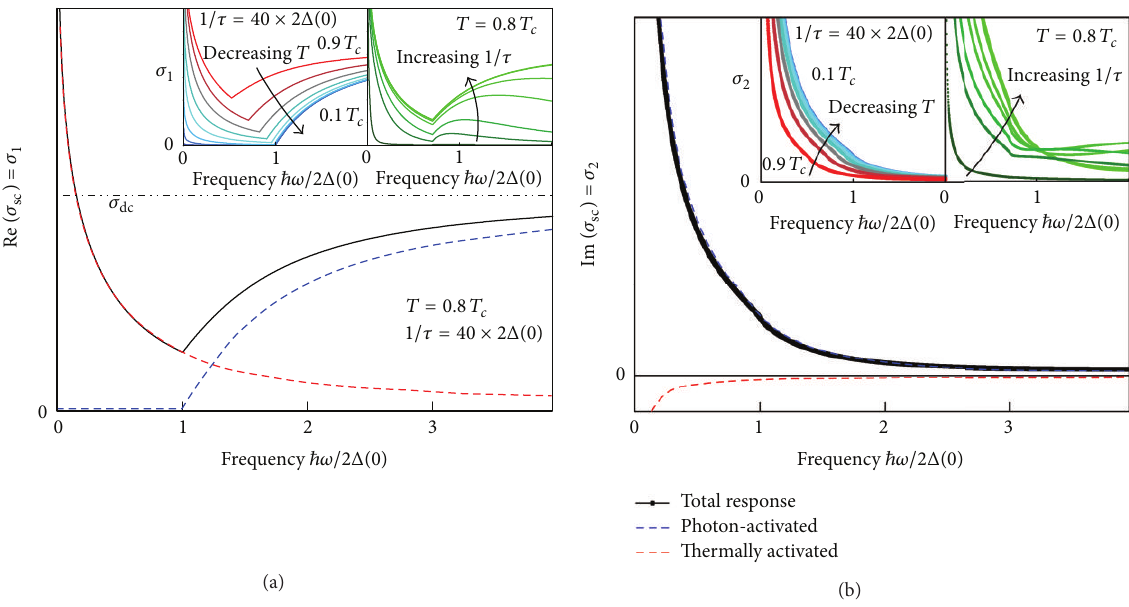
Figure 4: (a) Real and (b) imaginary parts of the complex optical conductivity (solid line) of a superconductor as a function of frequency based on generalized Mattis-Bardeen theory [27] for 𝑇 = 0.8𝑇 𝑐 and a finite scattering rate [28]. Dashed lines disentangle the contributions of both the thermal electrons [first term in (1) and dashed arrows in Figure 3(b)] and photon-activated electrons [second term in (1) and solid arrow in Figure 3(b)] to the conductivity. Insets of (a) and (b) show 𝜎 1 and 𝜎 2 for different temperatures ( 𝑇/𝑇 𝑐 = 0.9, 0.8, 0.7, 0.6, 0.5, 0.4, 0.3, 0.2, and 0.1) and scattering rates ( 1/𝜏 = 40, 20, 4, 2, 0.8, 0.4, and 0.04 ×2Δ(0)/ℏ) , respectively. (Used parameters 2Δ(0)/ℎ𝑐 = 25 cm −1 , 𝑇